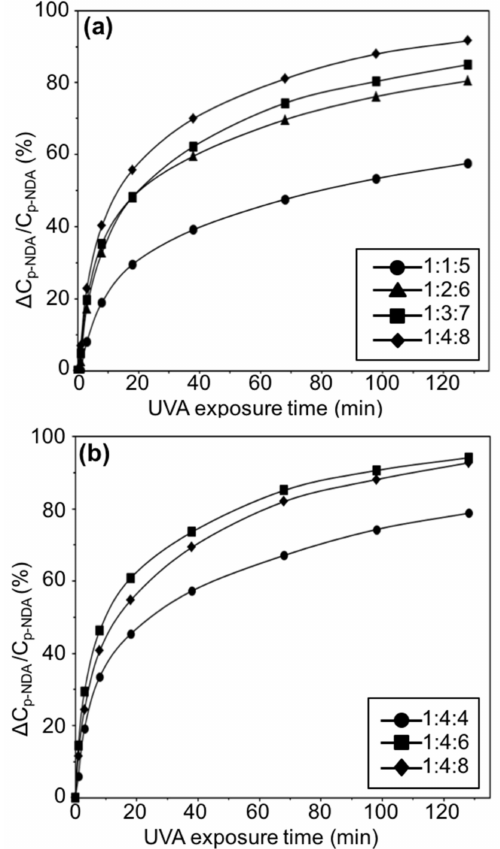
Figure 4. Photo-bleaching rates of p-NDA under UVA by AQ-CNCs made from ( a ) varied AQC / AGU molar ratios at a reaction time of 2 h and ( b ) varied AQC / CDI molar ratios at a reaction time of 24